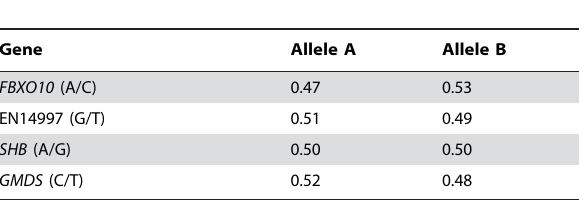
Table 4. Relative allele expression determined by allele- specific real-time